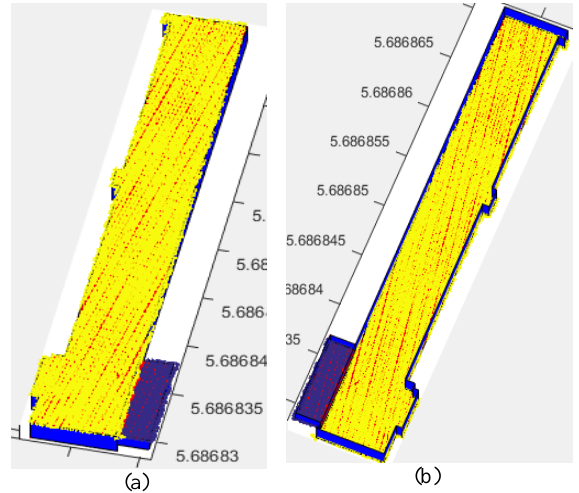
Figure 8. 3D flat building model with roof points (yellow points), a) top view, b) Lower view.